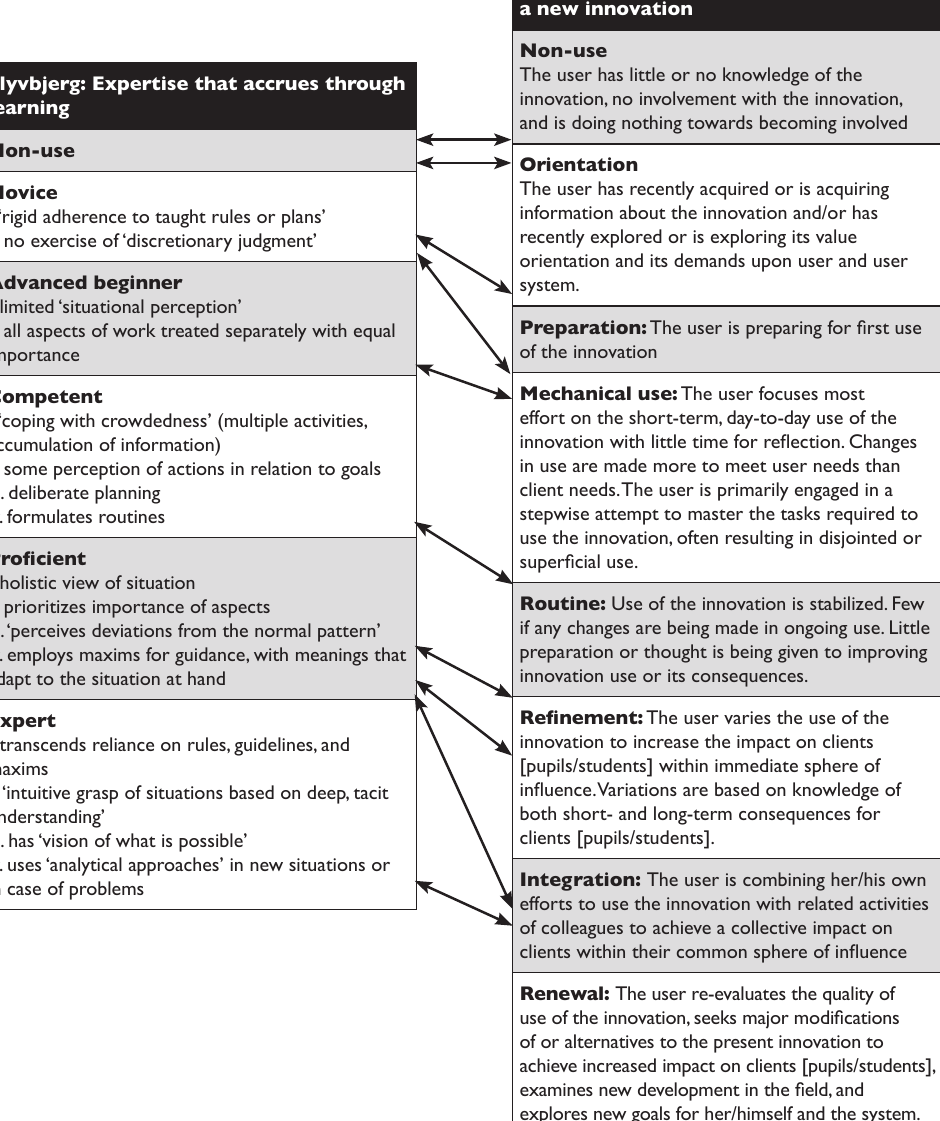
Figure 1: Congruence between Flyvbjerg (2003) and Hall and Hord (2015)